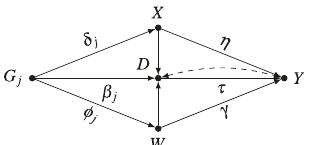
Fig. 4 DAG of the data-generating process for the simulation study (Eqs. (2) – (4)). For simplicity, only one G j is